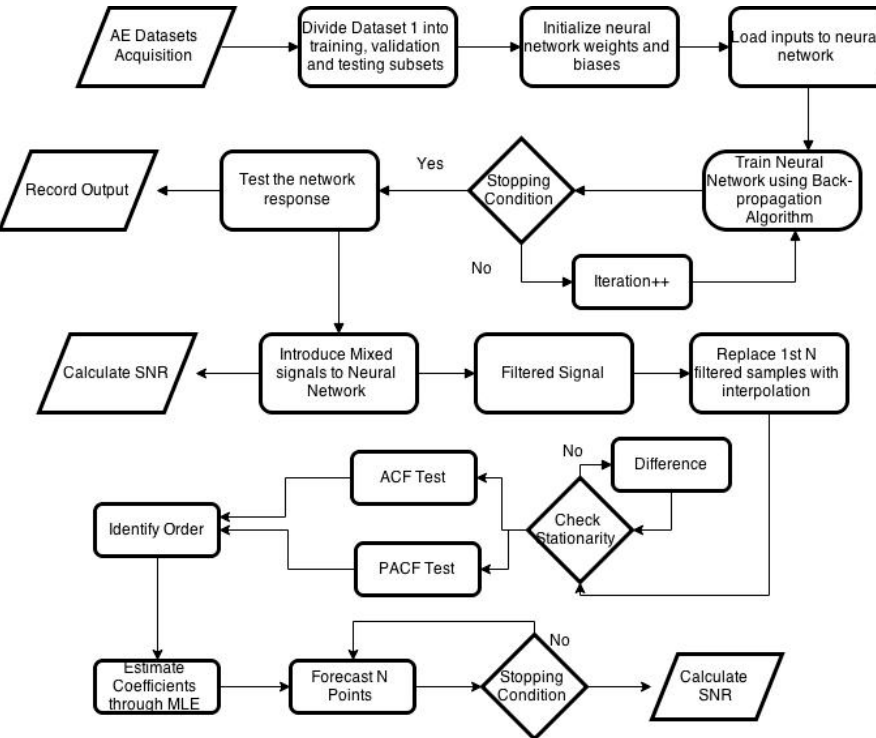
Figure 2 . Flowchart of the proposed algorithm. Figure 2. Flowchart of the proposed